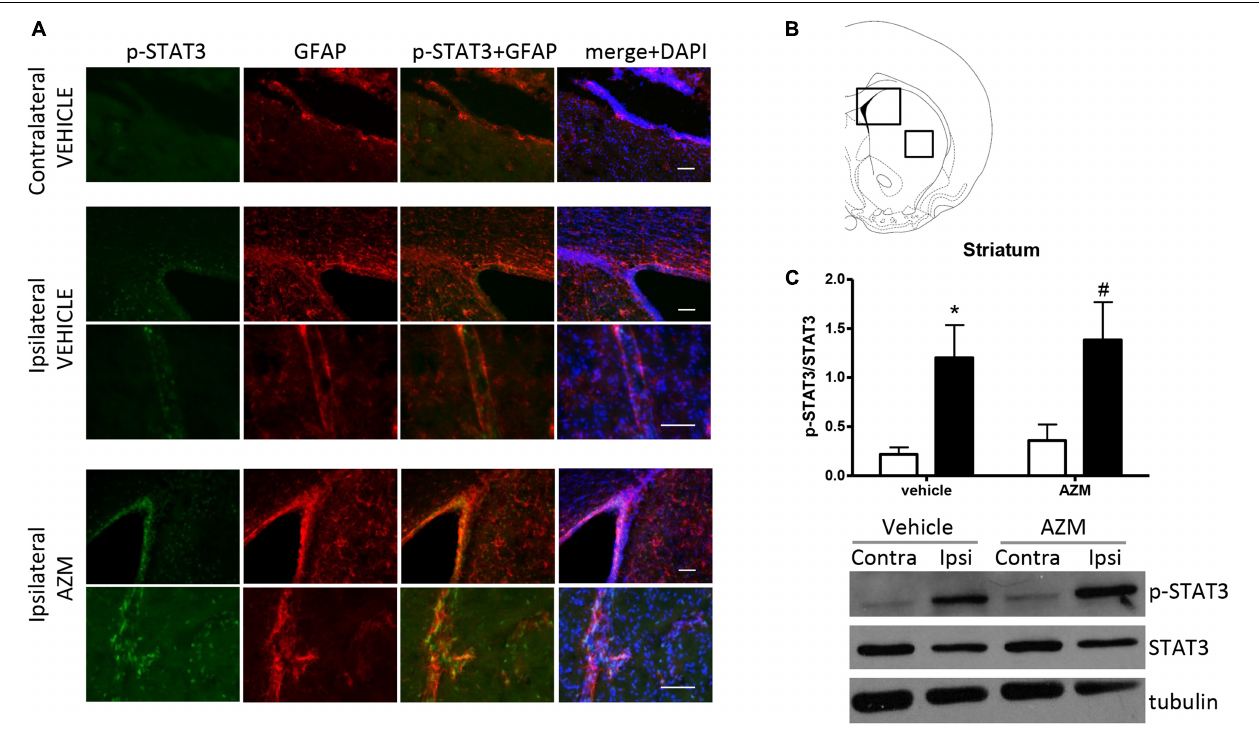
FIGURE 3 | Azithromycin does not affect elevation of STAT3 phosphorylation observed in the ischemic striatum of rats subjected to 2 h MCAo followed by 2 h of reperfusion. (A) Representative immunofluorescence images of the contralateral and ipsilateral (ischemic) striatum (insets in B ) of rats subjected to transient MCAo showing expression of p-STAT3 in some GFAP-positive periventricular astrocytes and in ependymal cells lining the lateral ventricle. Expression of p-STAT3 is also evident in intravascular leukocytes recruited to the ipsilateral striatum of both vehicle-injected and azithromycin-treated animals. Scale bars = 70 µ m. (C) Western blot analysis of phospho-STAT3 (Tyr705) (p-STAT3), total STAT3 and tubulin performed on brain homogenates from the ipsilateral (Ipsi, dark bars) and contralateral (Contra, white bars) striatum. Rats were treated with vehicle (0.9% NaCl) or azithromycin (AZM, 150 mg/kg), i.p., upon reperfusion. Data from the densitometric analysis of the autoradiographic bands are expressed as mean ± SEM of four independent experiments ( n = 4 rats per experimental group); ∗ P < 0.05 vs. vehicle contralateral and # P < 0.05 vs. AZM contralateral (two-way ANOVA for repeated measures followed by Bonferroni